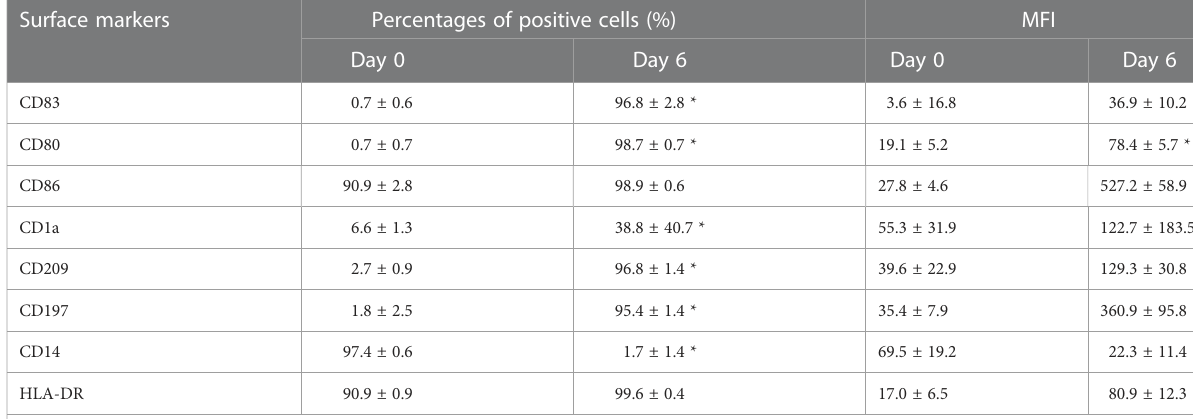
TABLE 3 Ef fi ciency of CD14 + monocyte-derived DC maturation.